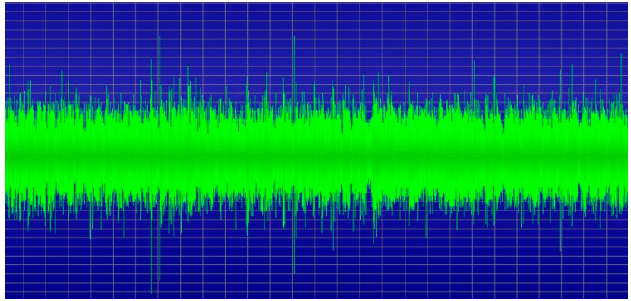
Figure 2. Collected analog radio signals.